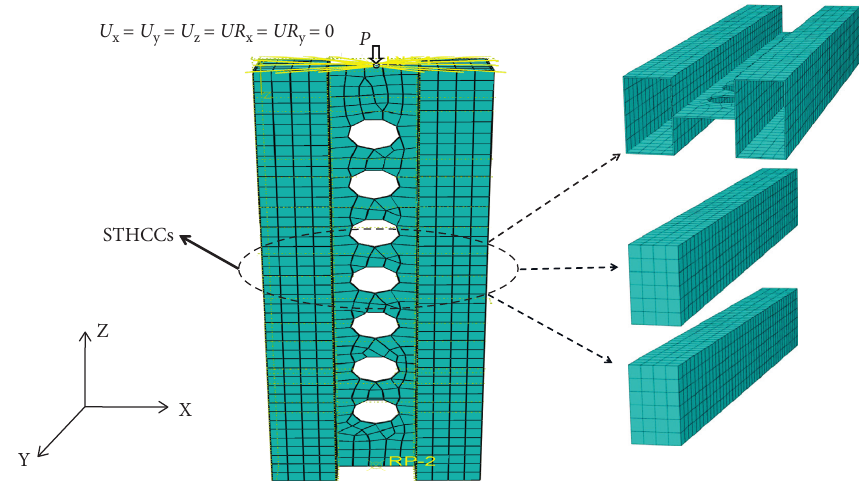
Figure 3: The FE model of STHCCs. Table 2: Comparison of simulation and test value subjected to axial